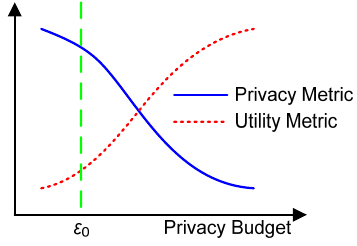
Figure 2. Model of trade-off of differential